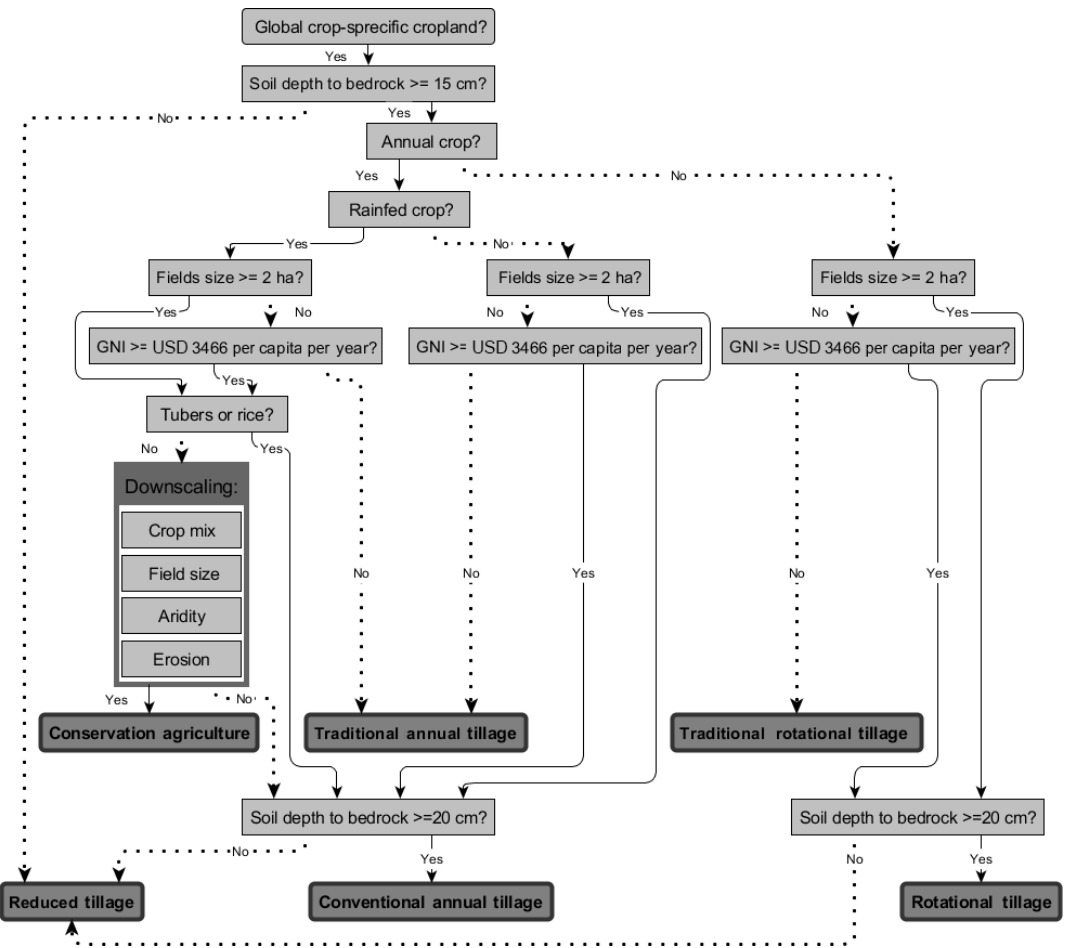
Figure 1. Decision tree for allocating cropland to six derived tillage systems. The data processing and mapping were pursued as depicted from top to bottom of the diagram. Each box represents a check on a grid cell of whether reporting values from the different data layers meet the derived thresholds or specific cropland features. The arrows with solid lines indicate a “yes” and arrows with dotted lines a “no” in the allocation procedure of crop-specific area to tillage systems. The box indicating the “Downscaling” represents our probability and suitability indicators applied to downscale national CA area values to a spatially heterogeneous pattern at per grid cell. Boxes with darker grey background shading and thicker frames show the derived types of tillage systems. (Abbreviation of gross national income as